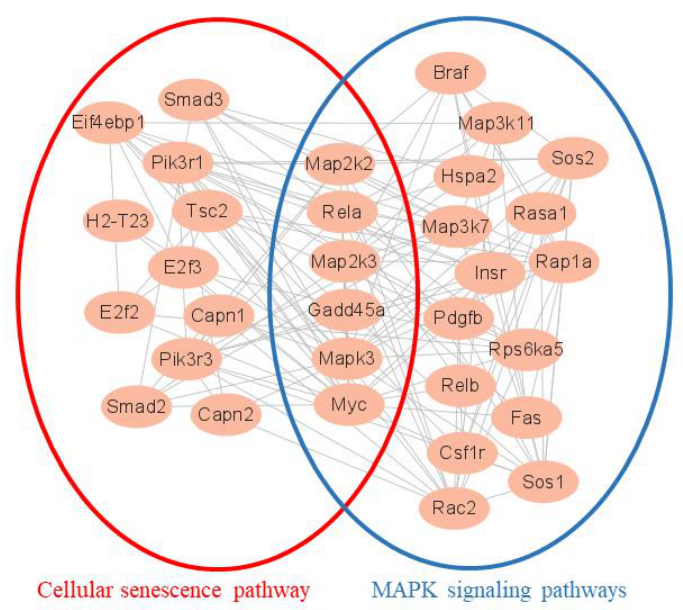
Figure 6. The protein-protein interaction subnetwork of all DEGs network in 160/LPS. Table 5. The six hub genes with the greatest degree of connection in subnetwork of 160/LPS. Gene Symbol Gene Description Degree Mapk3